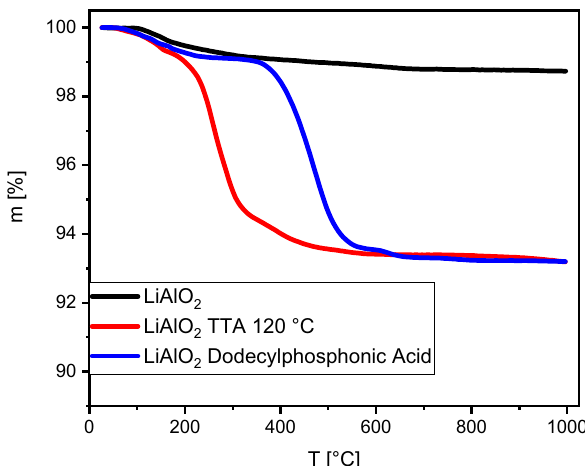
Figure 6. Selected TGA measurements of functionalized LiAlO 2 conditions 63 .